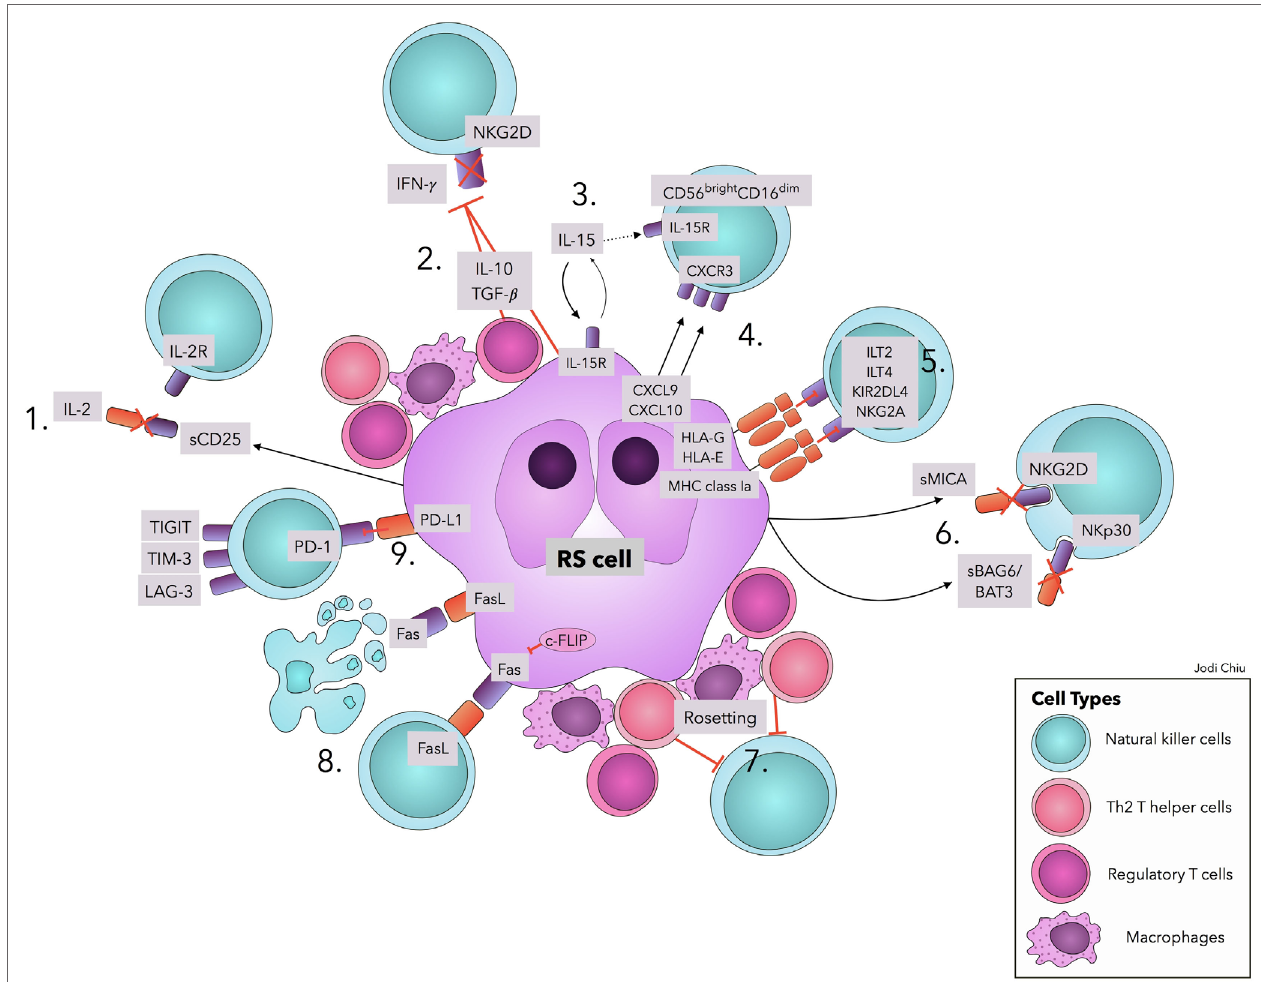
FiGURe 1 | Natural killer cell evasion mechanisms in cHL. The accumulation of NK cell evasion mechanisms in cHL TME explains the persistent failure of NK cell infiltration and activity observed in patients. (1) sCD25 blocks IL-2 interaction with IL-2Rs on NK cells. (2) TGF- β and IL-10 repress IL-2 and IFN- γ production and downregulate NKG2D expression. (3) IL-15 is used by RS cells for proliferation and survival, diminishing available IL-15 in TME for NK cells. (4) Upregulation of CXCL9 and CXCL10 on RS cells attracts CXCR3-expressing CD56 bright –CD16 dim NK cells, with lower efficacy in RS killing. (5) Interactions of MHC class I molecules, HLA-G, and HLA-E with corresponding inhibitory receptors suppress NK cell activity. (6) sMICA and sBAG6/BAT3 lead to NKG2D and NKp30 downregulation, respectively. (7) A physical barrier (“Rosetting”) consisting of Th2 T-helper cells, regulatory T cells, and macrophages shields RS cells from NK cells. (8) RS cells avoid Fas-mediated apoptosis by overexpressing c-FLIP. Expression of FasL on RS cells leads to apoptosis of Fas-expressing NK cells. (9) Interaction of PD-L1 with the cognate receptor PD-1 inhibits NK cell activation. Ligands in cHL for immune checkpoints TIGIT, TIM-3, and LAG-3 remain to be explored. Abbreviations: c-FLIP, cellular FLICE-inhibitory protein; cHL, classic Hodgkin Lymphoma; FasL, Fas ligand; IFN- γ , interferon- γ ; IL, interleukin; IL-2R, IL-2 receptors; ILT, Immunoglobulin-like transcript; KIRs, Killer cell immunoglobulin-like receptor; LAG-3, lymphocyte-activation-gene-3; NK, natural killer; PD-1, Programmed cell death protein-1; PD-L1, Programmed death-ligand 1; RS, Reed–Sternberg; s, soluble; TGF- β , Transforming Growth Factor- β ; TIGIT, T-cell immunoreceptor with Ig and ITIM domains; TIM-3, T-cell immunoglobulin and